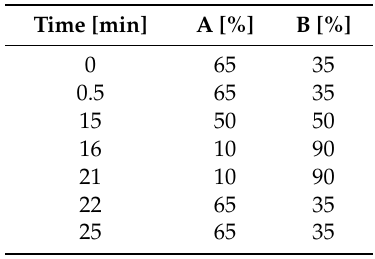
Table 1. The percentage composition of the mobile phase (A: H 2 O + 0.1% FA; B: Acetonitrile + 0.1% FA) in gradient HPLC-MS